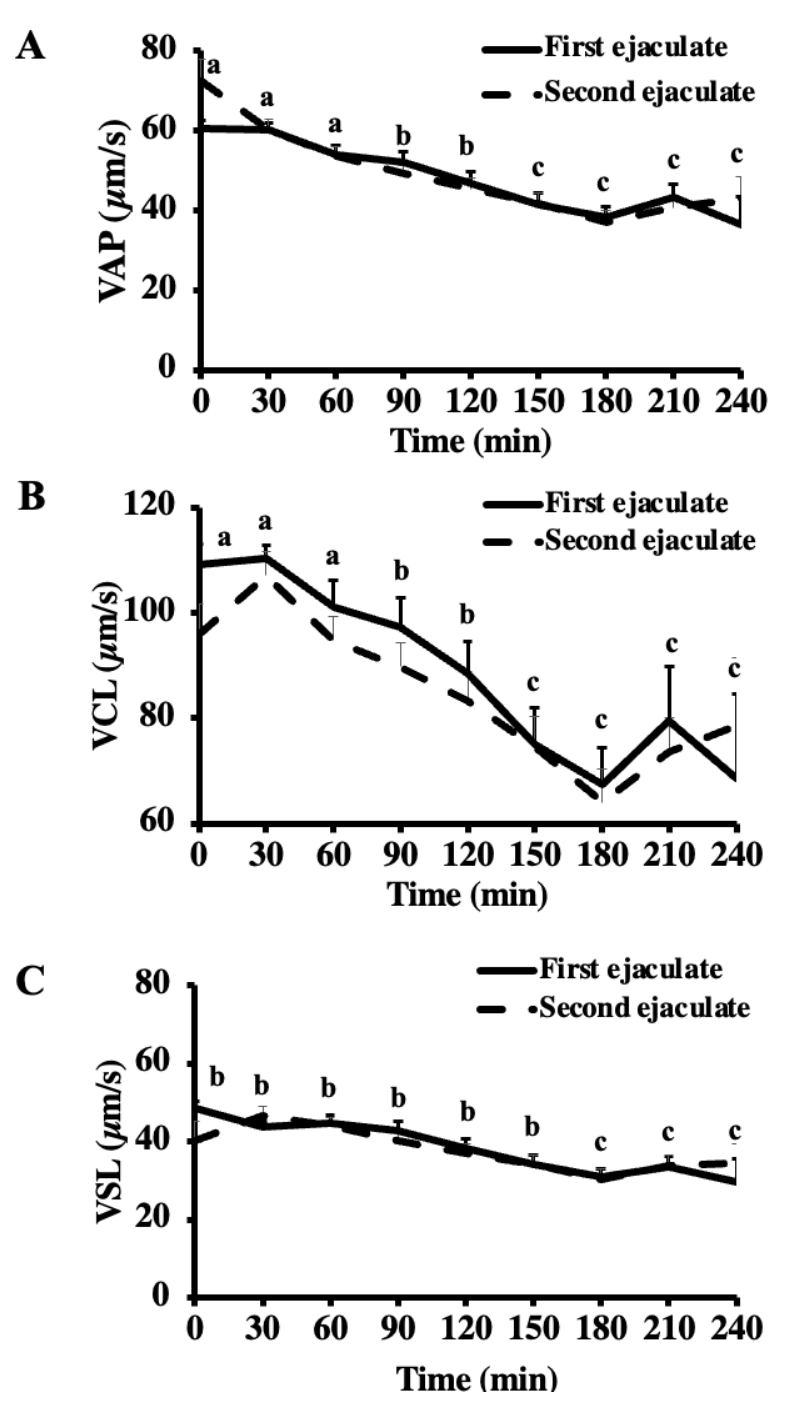
Figure 3. Velocity parameters (( A ) VAP; ( B ) VCL; ( C ) VSL) of the first and second ejaculates collected from breeding inactive stallions (n = 20). The frozen-thawed semen was incubated at 37 °C for 240 min. Different superscripts ( abc ) denote a difference between columns ( p < 0.05).